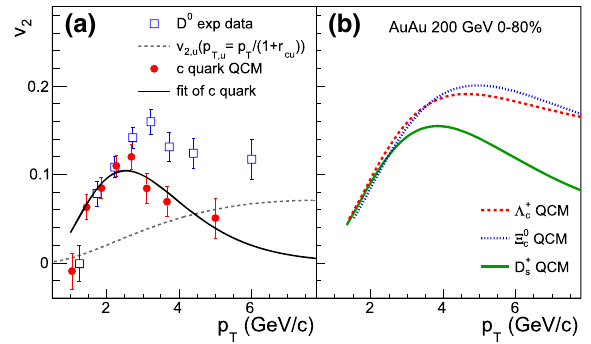
Fig. 6 Panel a Charm quark v 2 extracted from midrapidity data of D 0 √ s NN = 200 GeV for 0–80% centrality [18], in Au+Au collisions at and b predictions for D + s , Λ + c and Ξ 0 c in